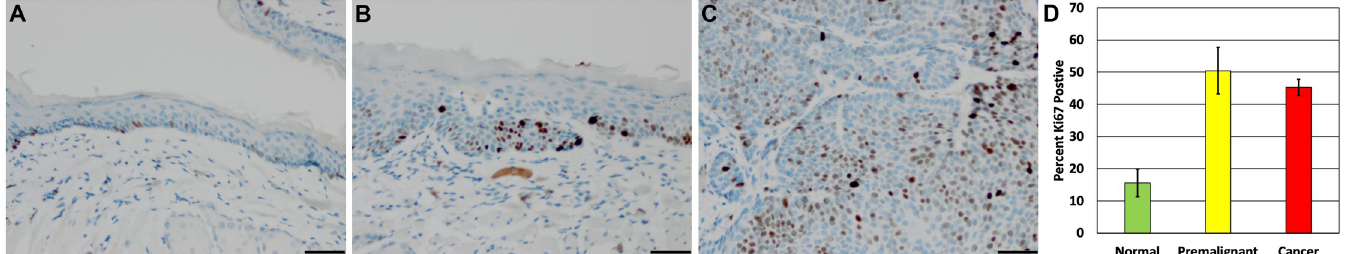
Fig 2. Ki67 increases in DBPDE treated mice. (A) Ki67 staining of normal tissues demonstrates a low proliferative index in the basal layers of the epithelium. (B) Dysplastic lesions have an increase in proliferation that is expanded beyond just the basal layer. (C) Regions of invasive cancer have wide-spread increases in proliferation. Scale bar = 50uM. n = 15. (D) Quantification of the percentage of Ki67 positive cells measured by counting 40x images (n = 3).